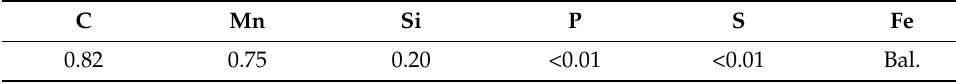
Table 1. Chemical compositions of SWRS82B steel (wt.%).